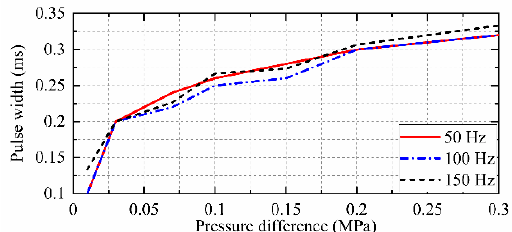
Figure 6. The minimum pulse width of three different PWM frequencies under different pressure differences.